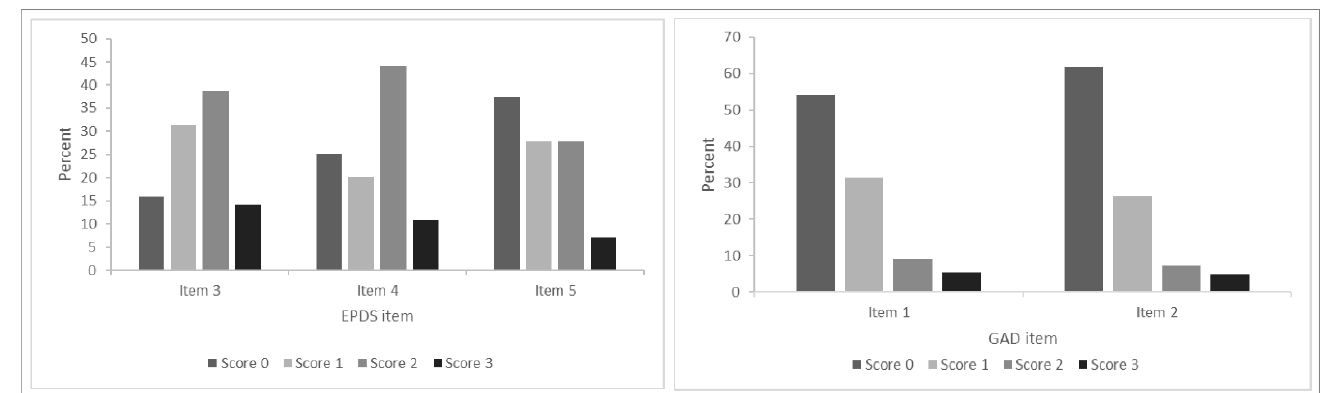
Figure 2. Distribution of scores on individual items of the GAD-2 and EPDS-3A.